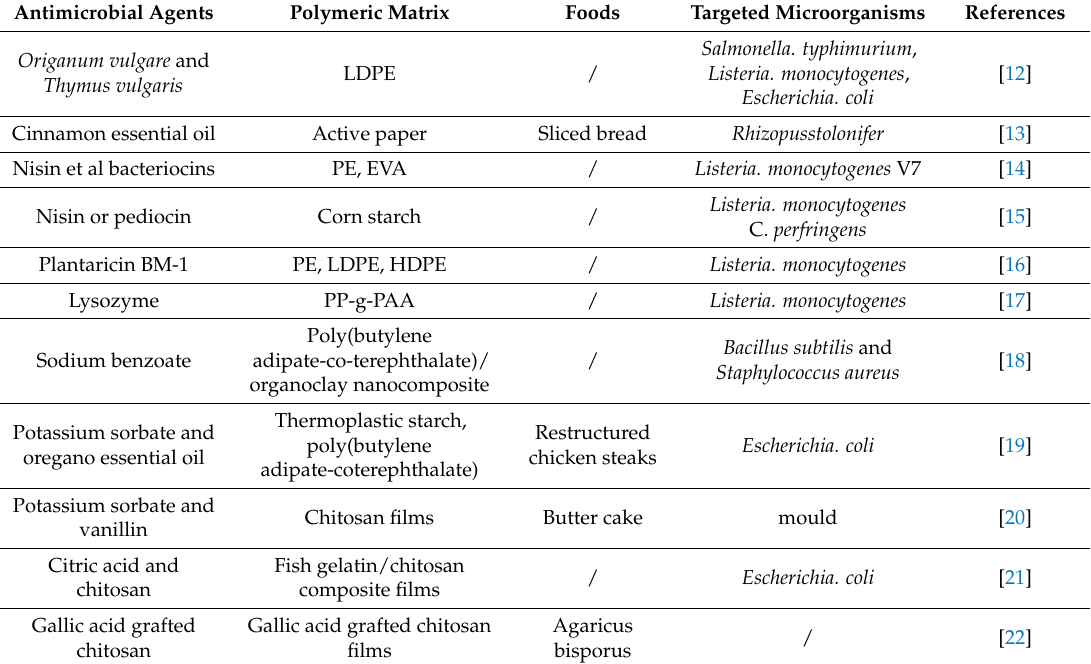
Table 1. Antimicrobial agents incorporated into polymeric matrix and their applications in food